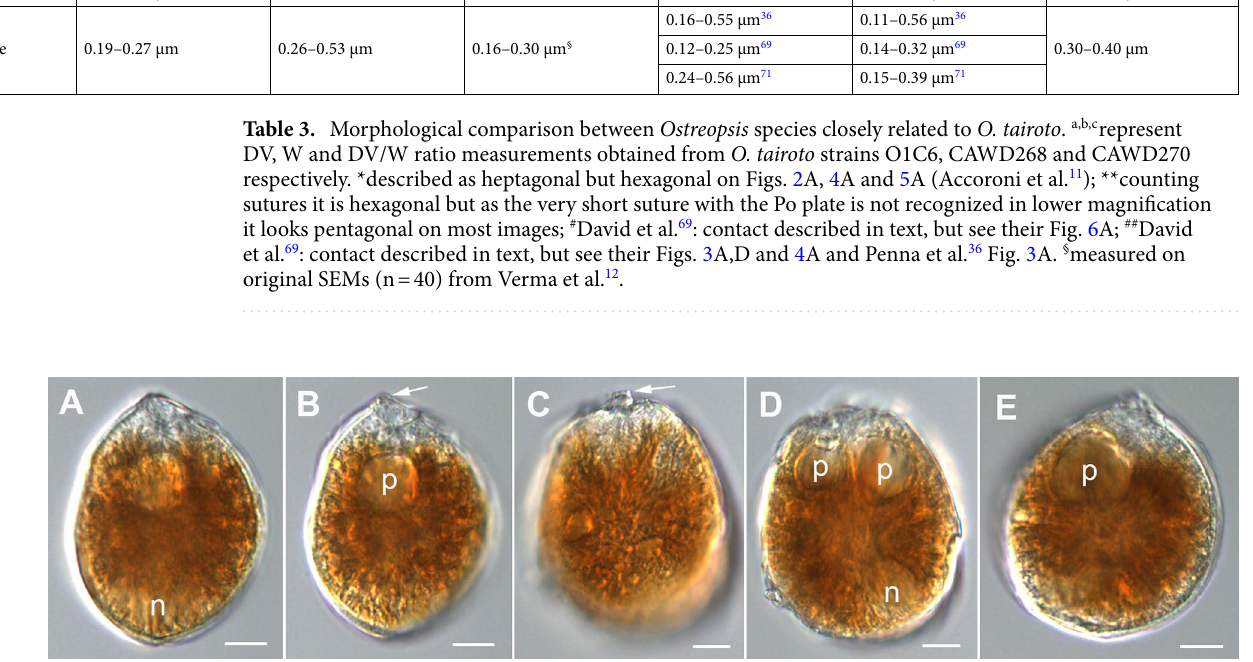
Figure 5. Light micrographs of Ostreopsis lenticularis strain C202 showing the cell shape and general features. ( A,B ) Same drop-shaped cell in different focal layers. Note nucleus (n), pusule (p) and ventral opening (arrow). ( C,D ) Same broadly oval to ovoid cell in different focal layers. Note the ventral opening (arrow) in C and the nucleus (n) and two pusules (p) in ( D ). ( E ) A relatively round cell with pusule (p). Scale bars = 10